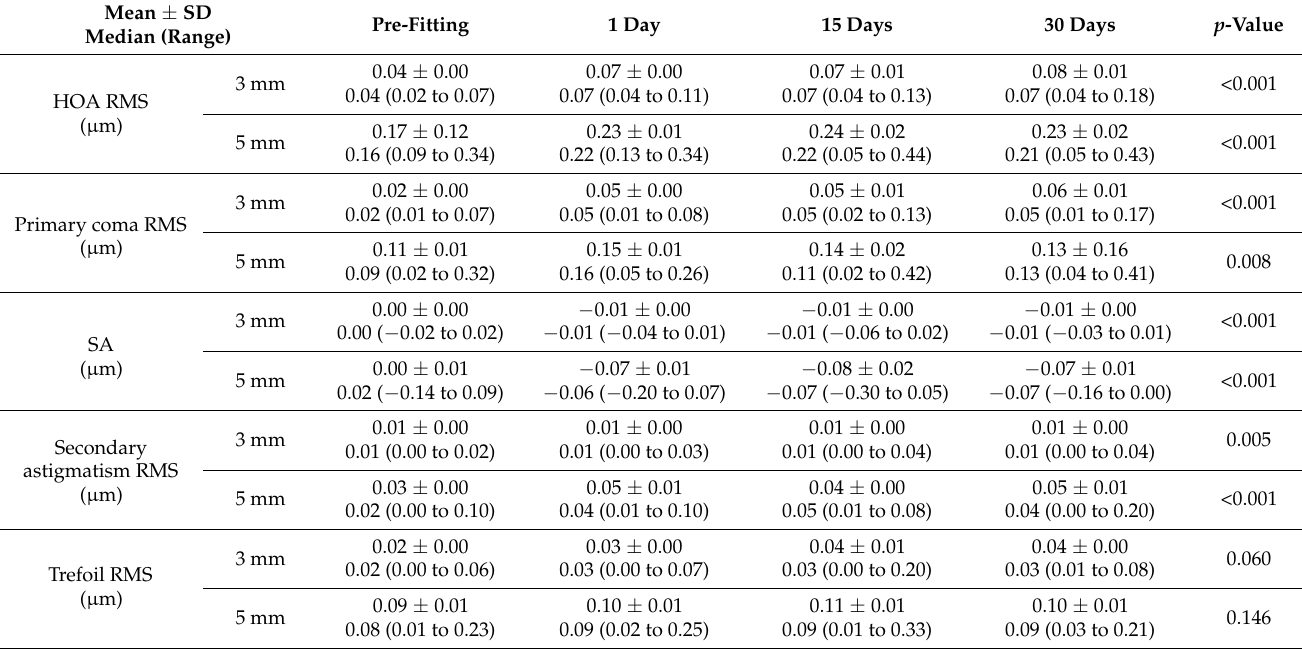
Table 4. Ocular aberrometric data measured at baseline and during the post-fitting period in the current study. Abbreviations: SD, standard deviation; HOA, high order aberration; RMS, root mean